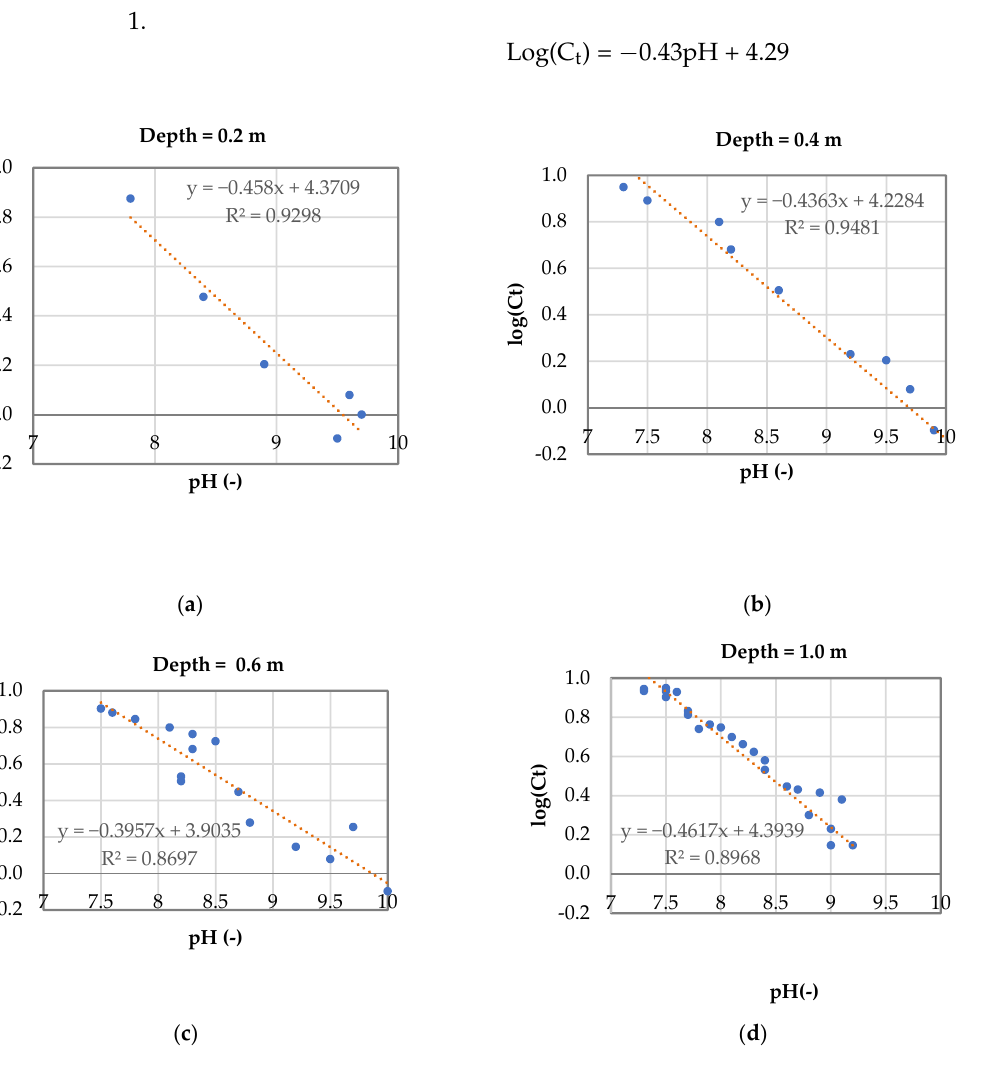
Figure 5. ( a ) Experimental data and simulated curve for nitrogen as function of time for SBPP with a depth of 0.2 m; ( b ): Experimental data and simulated curve for nitrogen as function of time for SBPP with a depth of 0.4 m, ( c ): Experimental data and simulated curve for nitrogen as function of time for SBPP with a depth of 0.6 m, ( d ): Experimental data and simulated curve for nitrogen as function of time for SBPP with a depth of 1.0 m.